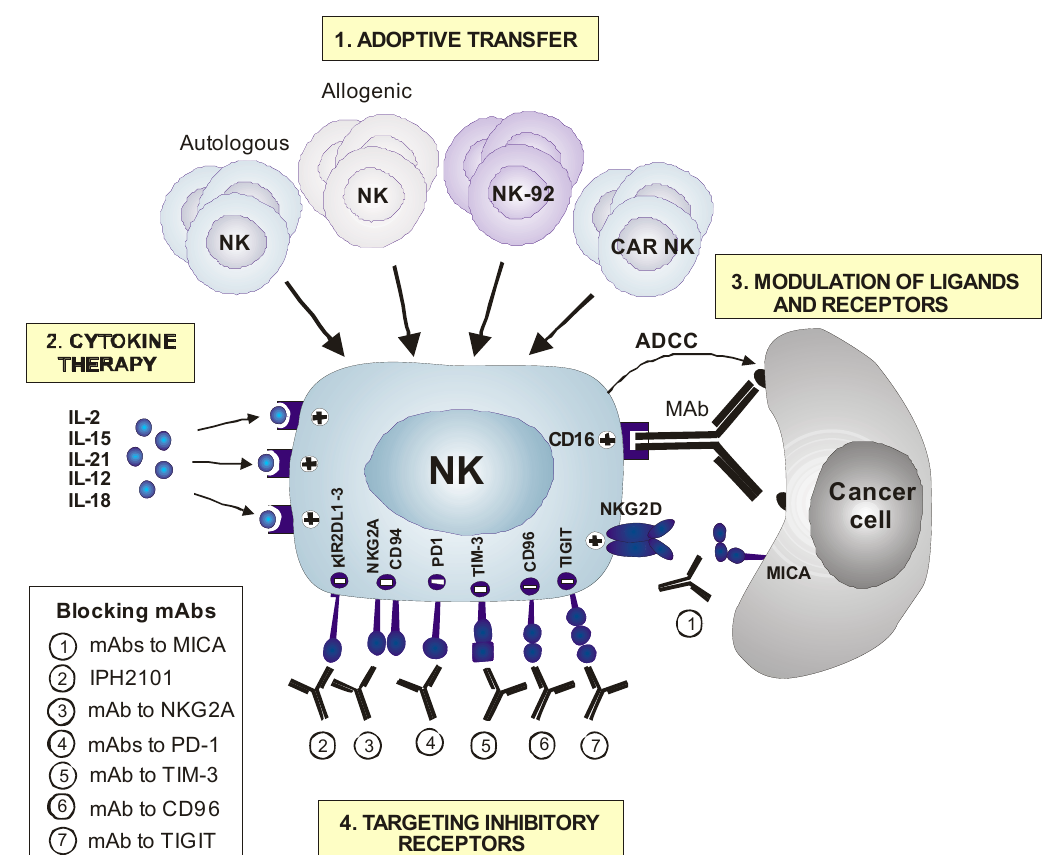
Figure 1. Therapeutic approaches involving Natural Killer (NK) cells to treat metastatic cancer. ( 1 ) The transfer of expanded and activated NK cells is increasingly used to improve NK cell responses. Autologous NK cells, allogenic NK cells, NK cell lines, such as NK-92 cells, or Chimeric Antigen Receptor (CAR) NK cells may be harnessed as a source of NK cells for adoptive transfer. ( 2 ) The activity of NK cells may also be stimulated by cytokine or drug treatment. IL-2, IL-15, and IL-21 are